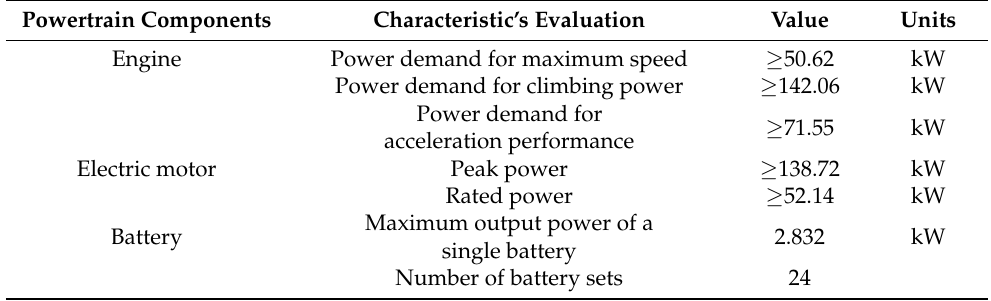
Table 3. Matched parameters of HEV key powertrain